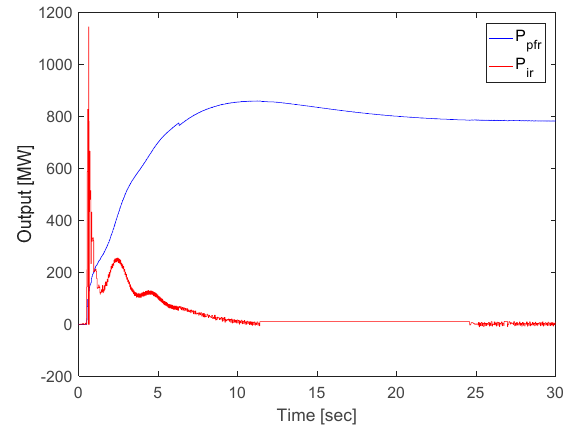
Figure 12. ESS power output element with adaptive droop.